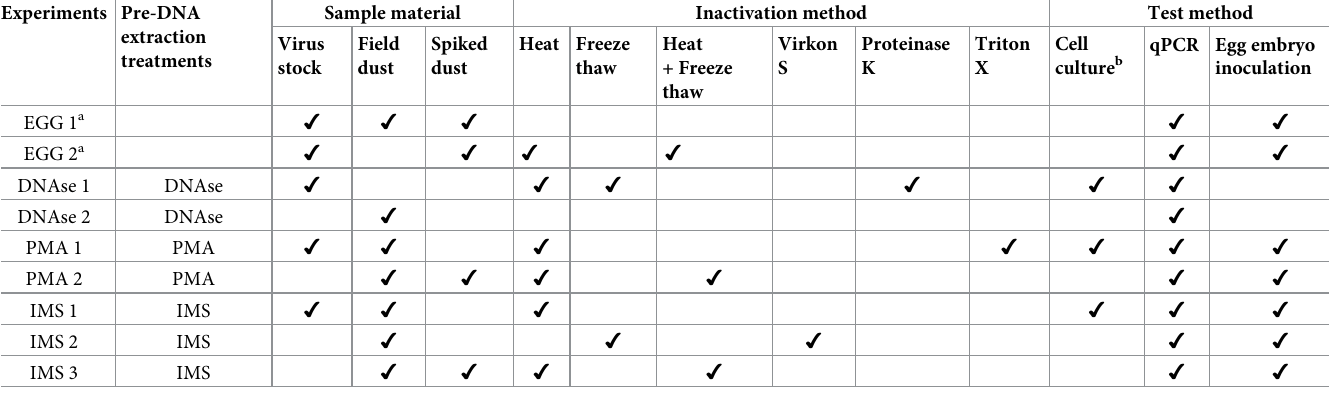
Table 1. Summary of experiments carried out and treatments and methods used in each experiment. Chick embryo or cell culture assays were used to titrate the infec- tivity of samples used. Pre-DNA extraction treatments (DNAse, PMA, IMS) were then tested to assess their ability to prevent qPCR amplification of DNA from inactivated